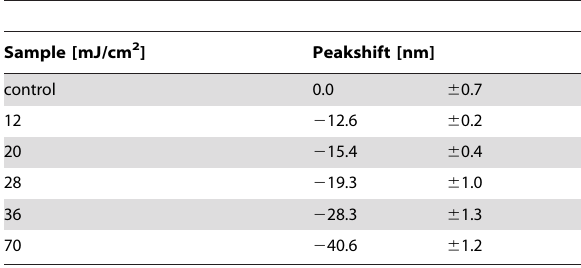
Table 1. Shift of the resonance absorbance peak in the absorbance spectra of AuNP after laser irradiation.